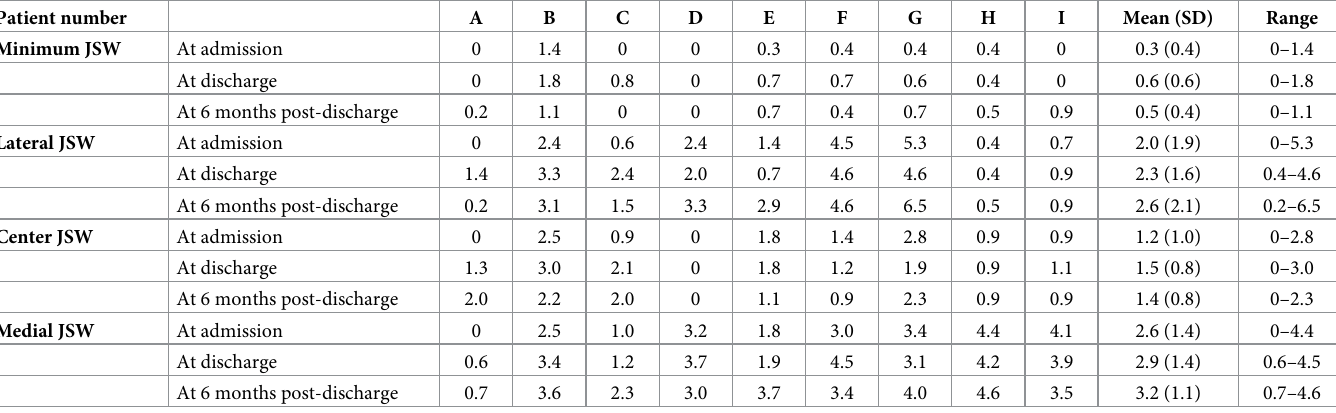
Table 2. Results of joint space width of the hip joint in nine patients